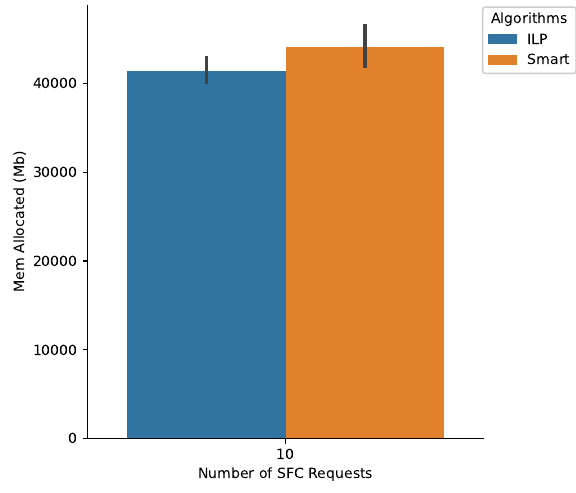
Figure 6. Allocated memory